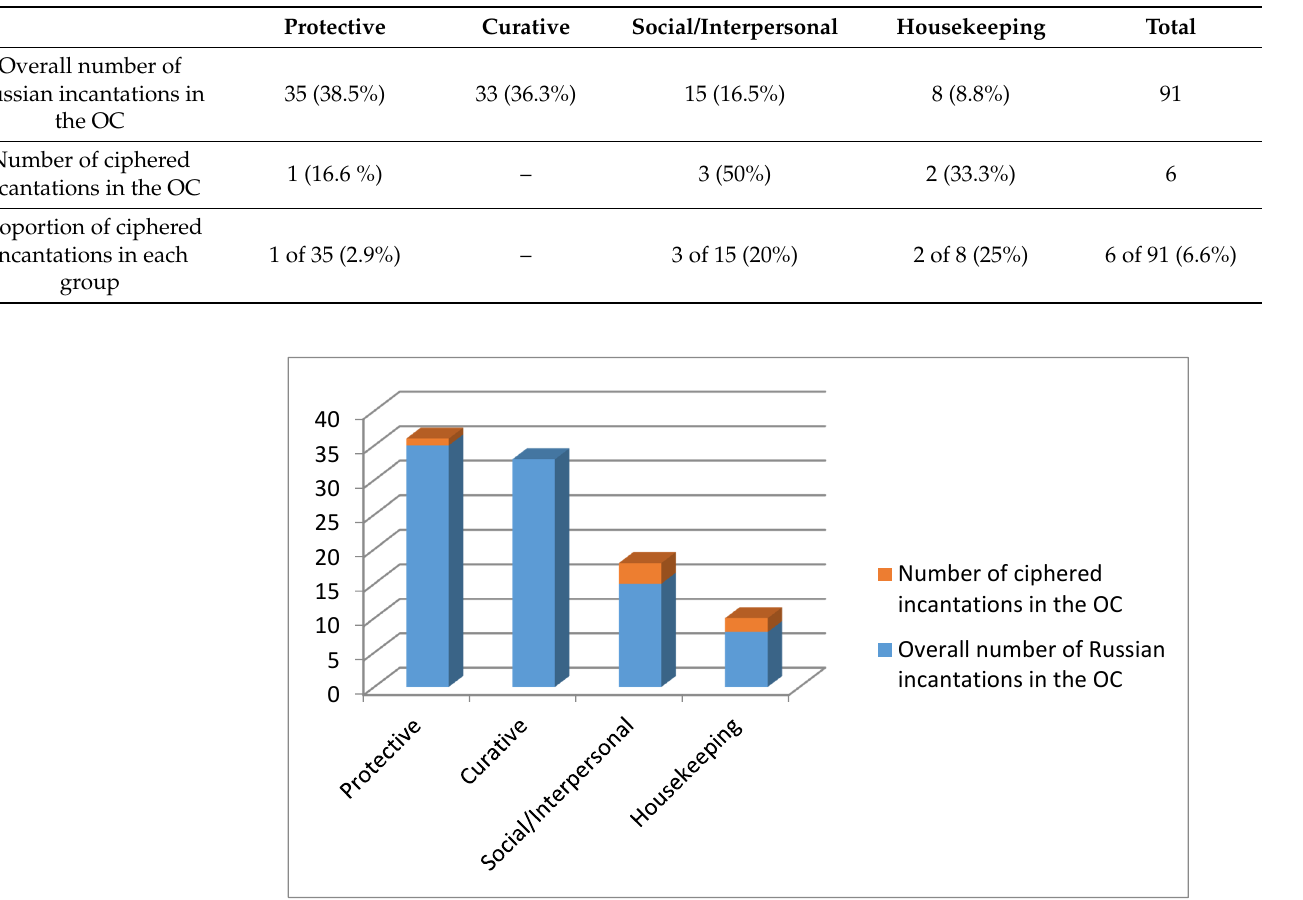
Figure 1. Distribution of ciphered Russian incantations in the OC.